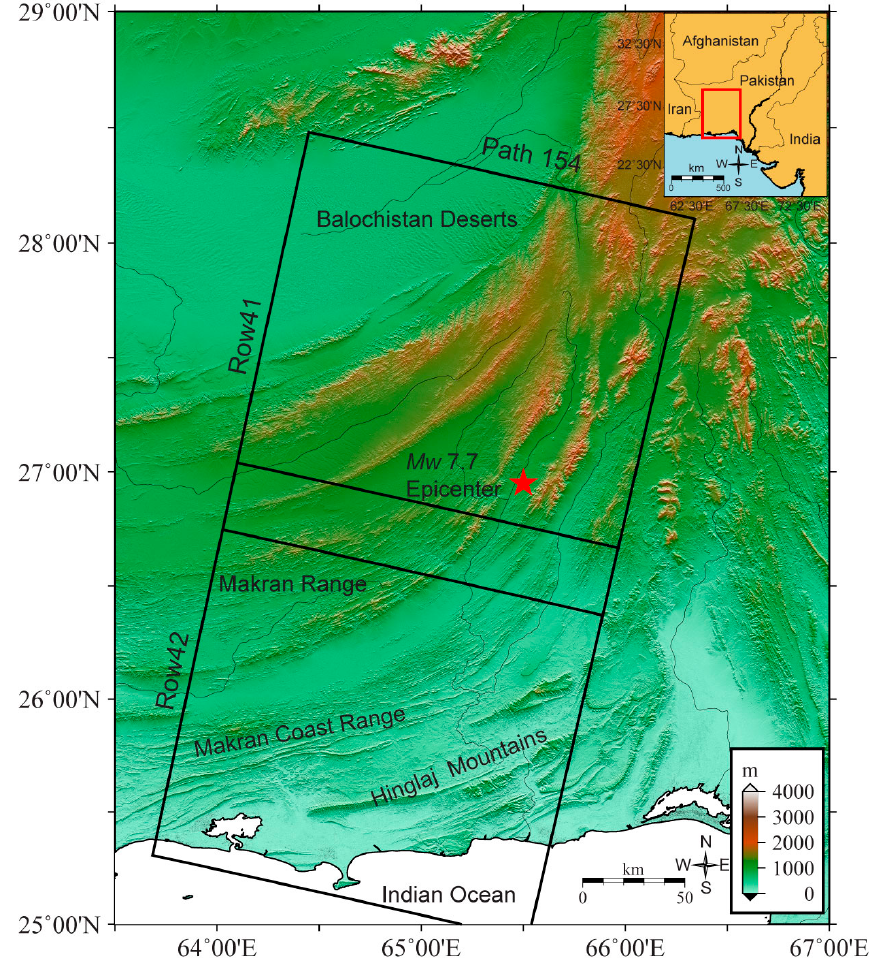
Figure 1. Coverage of Landsat 8 images over the study area. The red star indicates the epicenter of the 2013 Mw 7.7 Balochistan, Pakistan earthquake. The black boxes are the footprint of the Landsat 8 images in this study. The red rectangle frame in the inset represents the approximate location of the study area in Pakistan.